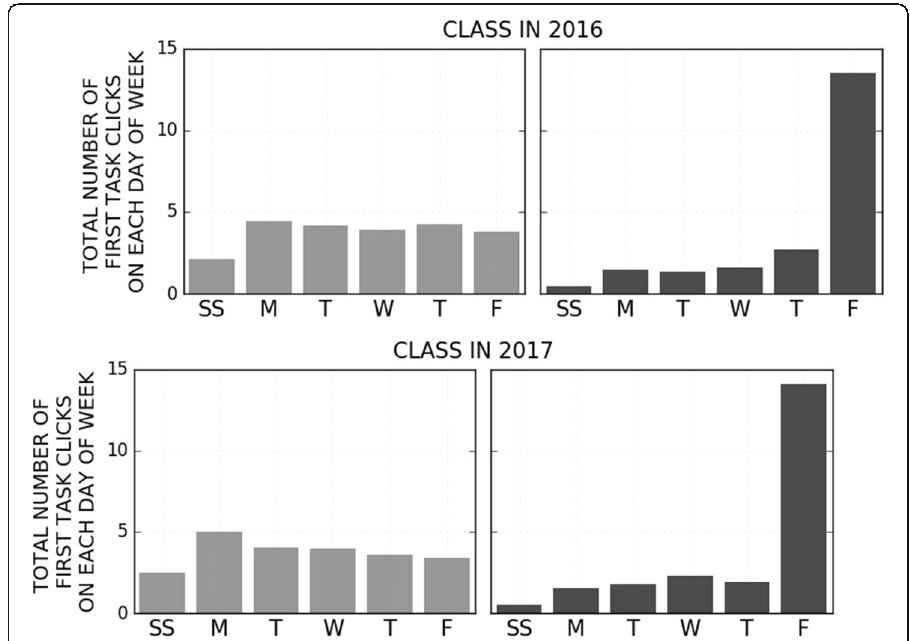
Fig. 5 Poisson mixture component means from modeling aggregated daily task counts for the class in 2016 (upper) and 2017 (lower). The left panels show aggregated daily counts for non-procrastinators and the right panels for procrastinators. Figure based on data and analyses in Park et al.